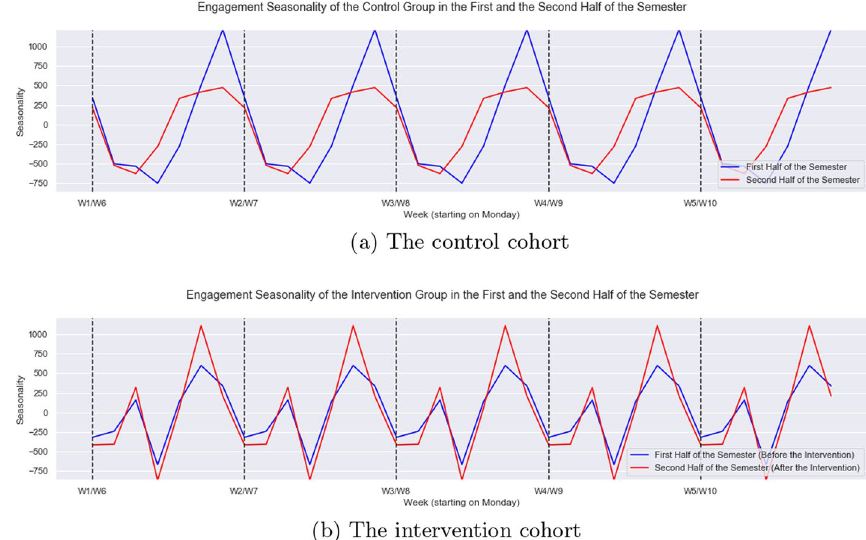
Fig. 3 Extracted seasonality of AvgStrCountPerDay of the control cohort ( a ) and the intervention cohort ( b ) compared between the first (blue) and the second half (red) of the semester (after the